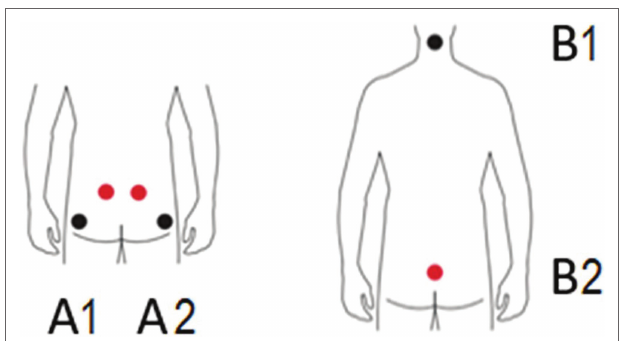
FIGURE 1 | Positions of the electrodes. The picture was taken from JeeCee International NV with permission and adjusted. A1 and A2: upper and lower buttocks, B1: neck, and B2: